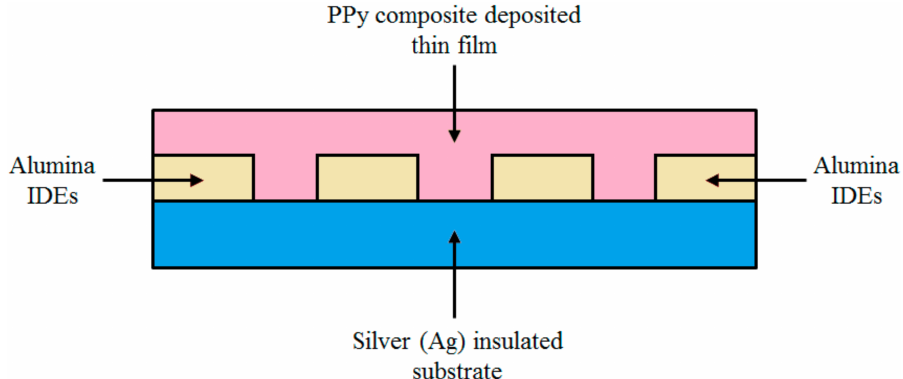
Figure 5. Cross-sectional view of the newly fabricated Ppy composite thin film resistive-type humidity sensor.